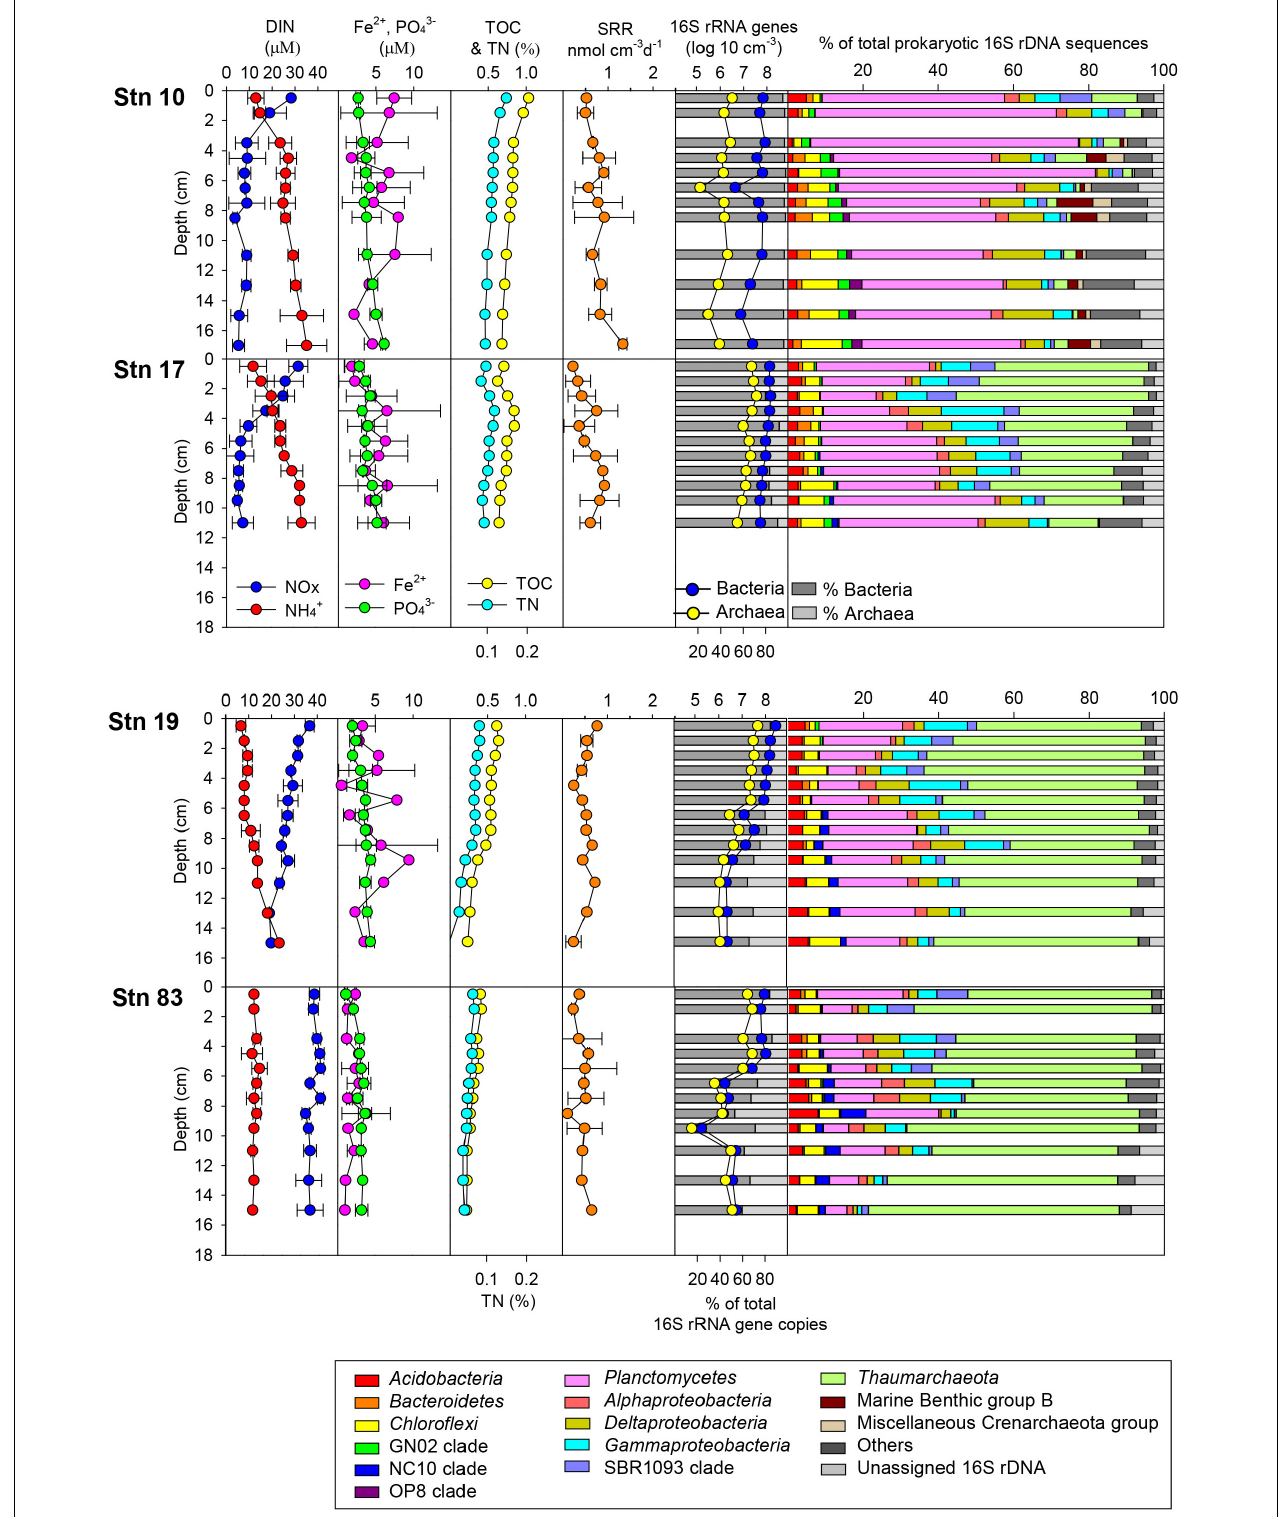
FIGURE 2 | Distribution of geochemical constituents [dissolved inorganic nitrogen (DIN; NH + 4 and NO x ), PO 3 − 4 and Fe 2 + ] in pore-water and contents of total organic carbon (TOC), total nitrogen (TN), sulfate reduction rate (SRR), prokaryotic cell abundance based on quantitative-PCR, and relative abundance of major phyla in the sediment of the polynya sites (Stns 10 and 17) and non-polynya sites (Stns 19 and 83) of the Amundsen Sea.